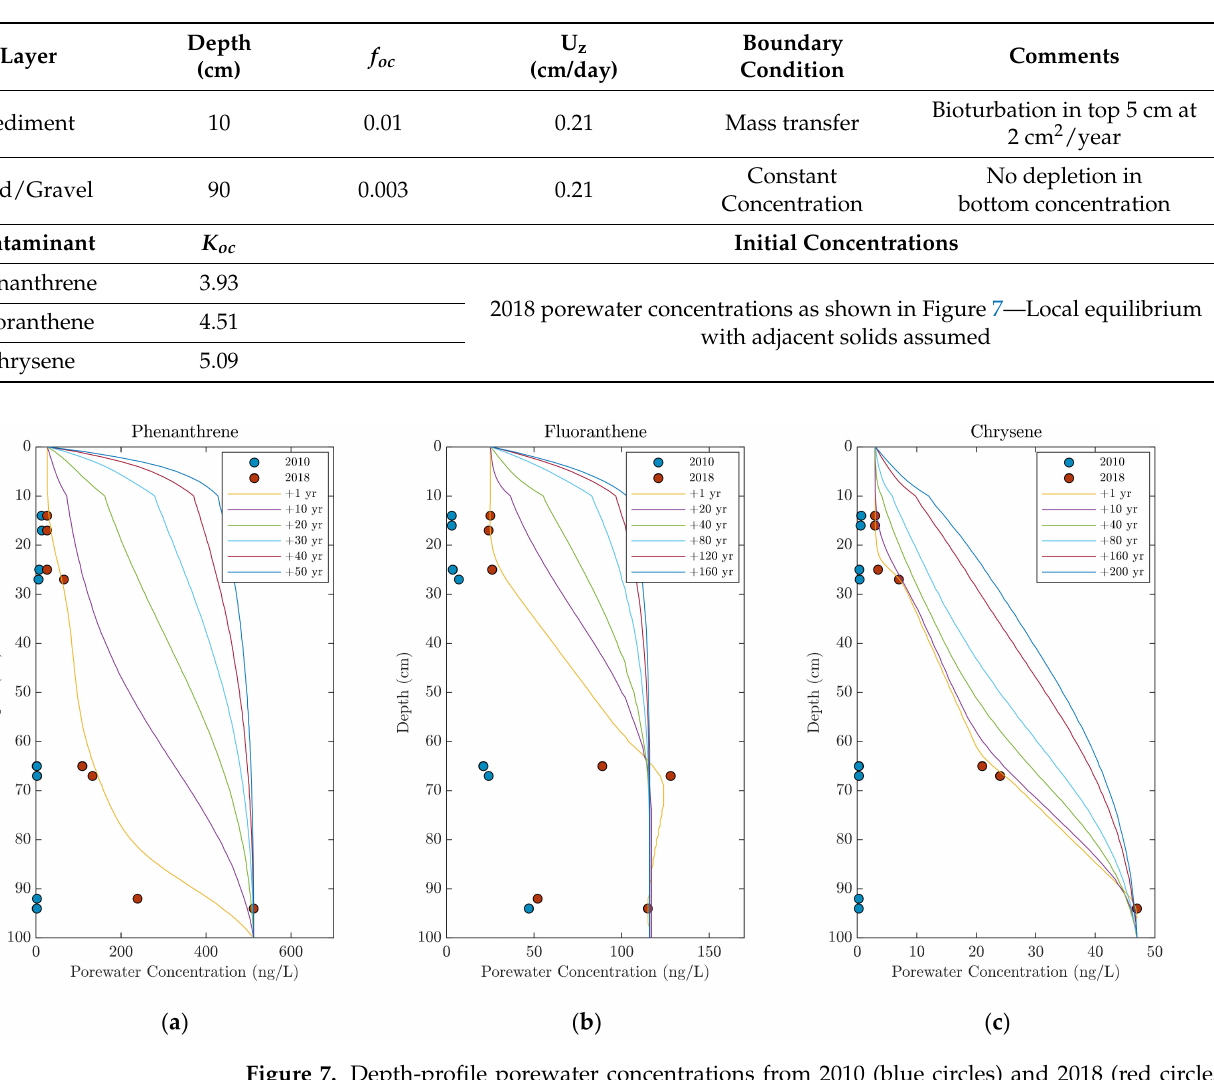
Table 3. Key model parameters for simulations shown in Figure 7.